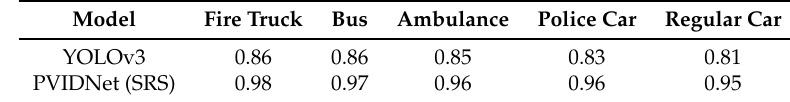
Table 17. Accuracy results classifying Fire Trucks, Buses, Ambulances, Police Cars, and Regular Cars using video stream data considering together the right, left, and front images.